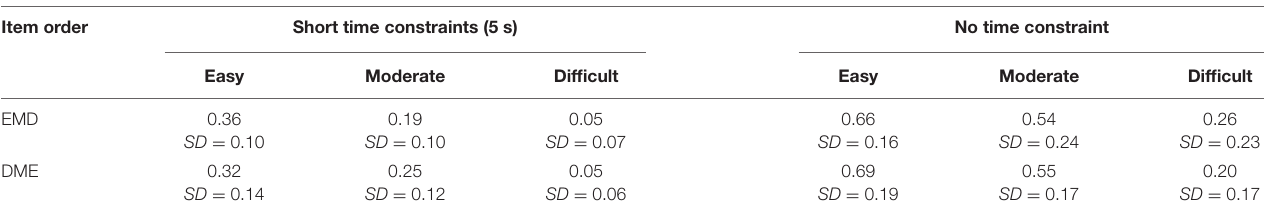
TABLE 2 | Test accuracies for Experiment 1 (Ms, SDs).